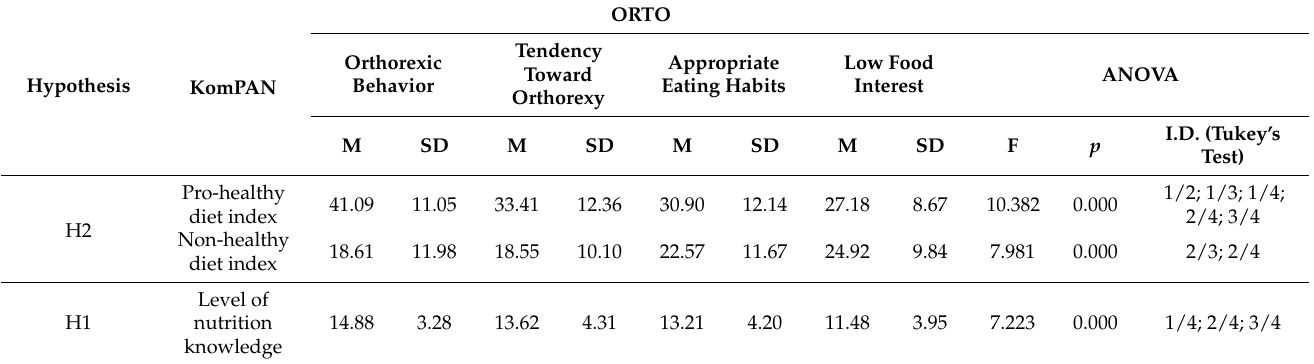
Table 3. Indexes of diet quality and the level of nutrition knowledge in the particular